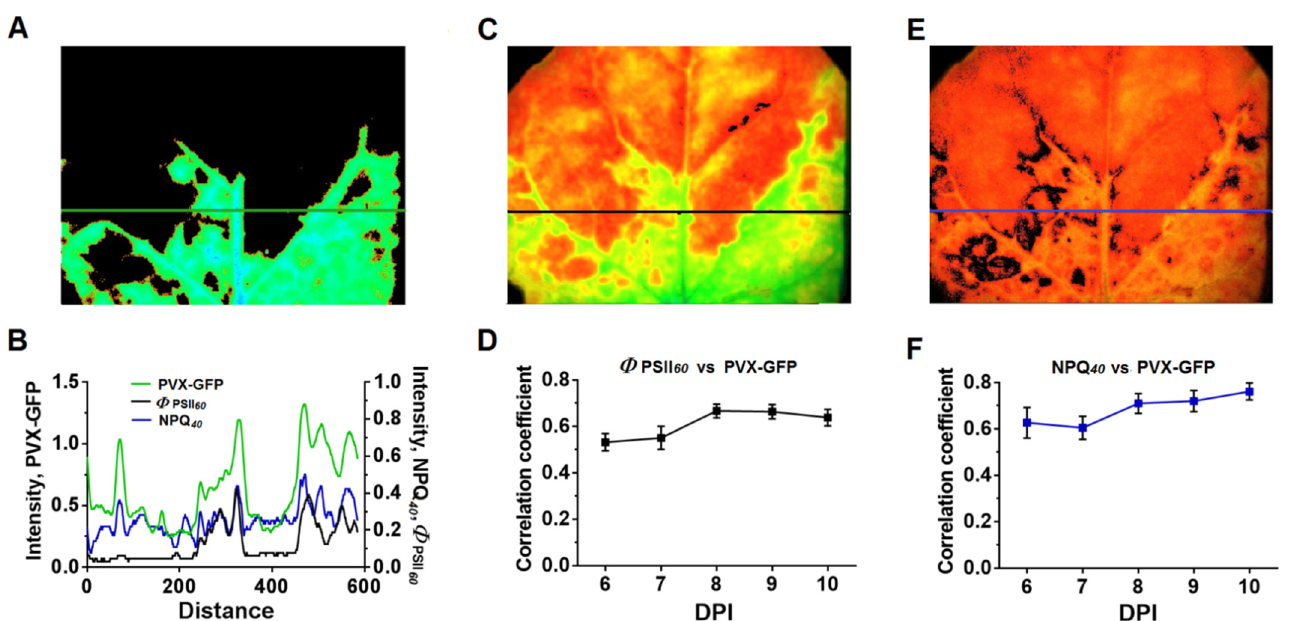
Figure 10. Relationship of ChlF parameters Φ PSII and NPQ with infection: ( A ) Fluorescence images of the infected 10th tobacco leaf ( λ ex 460 nm, λ em 500–540 nm). ( C ) Φ PSII image taken 60 s after the AL was switched on. ( E ) NPQ image taken 40 s after the AL was switched on. ( B ) Φ PSII , NPQ, and GFP fluorescence profiles determined from the lines shown in ( A , C , E ). ( D , F ) Dynamics of the coefficients of correlation of Φ PSII ( D ) and NPQ ( F ) values versus PVX-GFP fluorescence depending on the time after inoculation (DPI, day post-inoculation) ( n = 5); 6 DPI corresponds to the first day of PVX-GFP detection in the studied leaf. The Pearson correlation coefficients were calculated. Graphs ( D , F ) show mean values ± SEM.